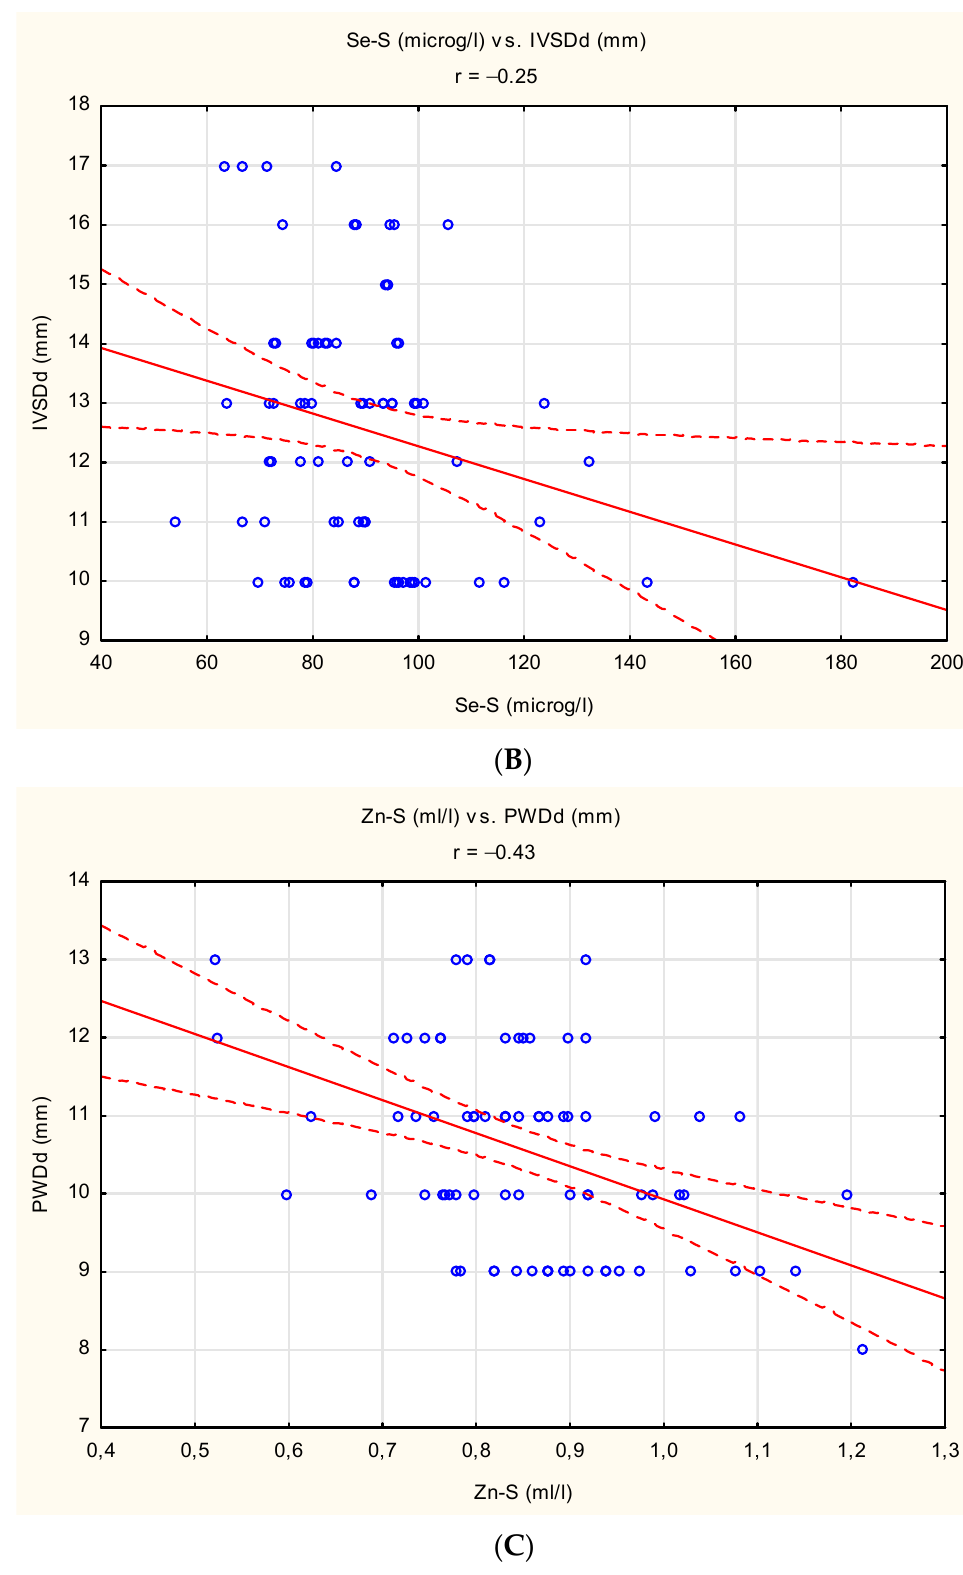
Figure 1. Statistically significant correlations in study group: ( A ) between Se-S and PWDd (r = − 0.34, p < 0.05). ( B ) between Se-S and IVSDd (r = − 0.25, p < 0.05). ( C ) between Zn-S and PWDd (r = − 0.43, p < 0.05).